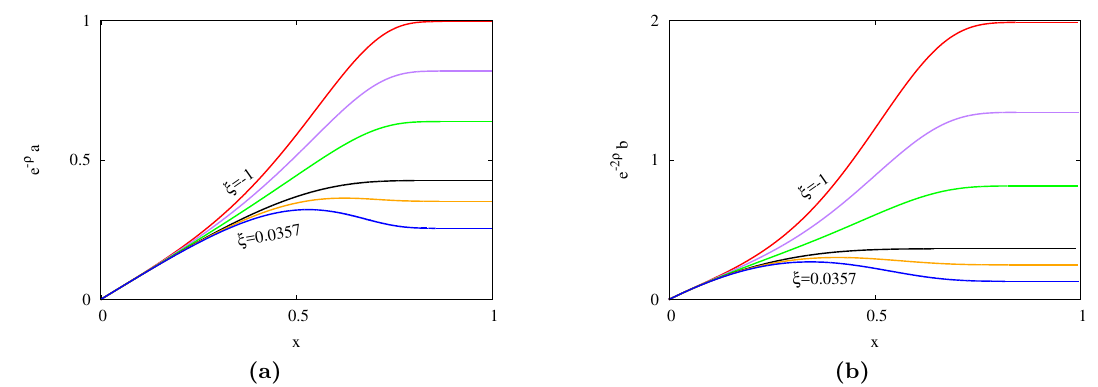
Figure 10. (a) Pro(cid:12)les for the function a (rescaled by a factor e (cid:0) (cid:26) ), as a function of the compact- i(cid:12)ed radial coordinate x = (cid:26)= ( (cid:26) + 1). From top to bottom we show the pro(cid:12)le for the values (cid:24) = (cid:0) 1 ; (cid:0) 0 : 5 ; (cid:0) 0 : 18 ; 0 ; 0 : 025 and 0 : 0357. (b) Similar pro(cid:12)les for the rescaled metric function b . Here and in (cid:12)gures 11{12a the results are shown for the same values of the near-horizon parameter (cid:24) (cid:17) (cid:11) 4 .